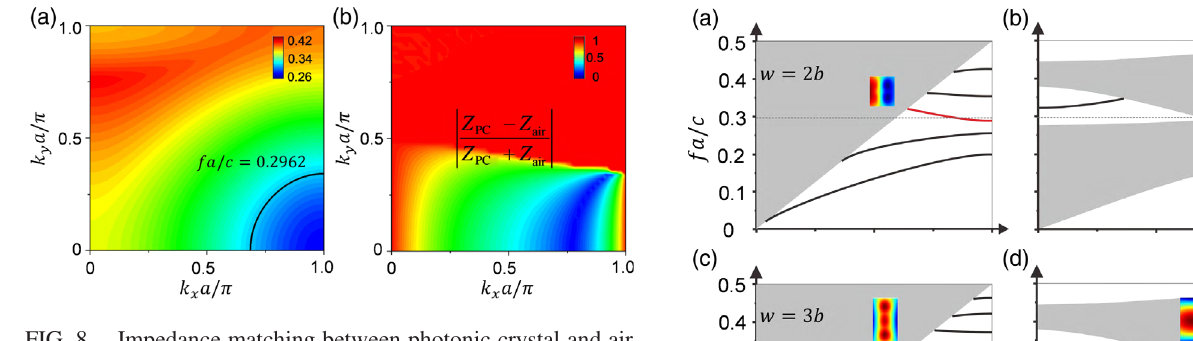
FIG. 8. Impedance matching between photonic crystal and air. (a) The EFCs of the second band of the PC II in Fig. 2. The black curve is the EFC at the working frequency fa=c ¼ 0 . 2962 . (b) The impedance difference between the PC and air of the second band.